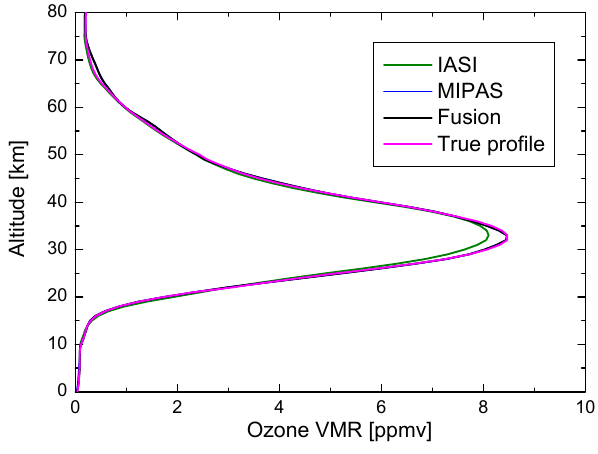
Fig. 1. Results of the simulation showing the true ozone VMR pro- file (magenta line) and the profiles retrieved using only the IASI measurement (green line), only the MIPAS measurement (blue line) and the IASI-MIPAS data fusion (black line). The magenta, blue and black lines overlap across the entire altitude range.